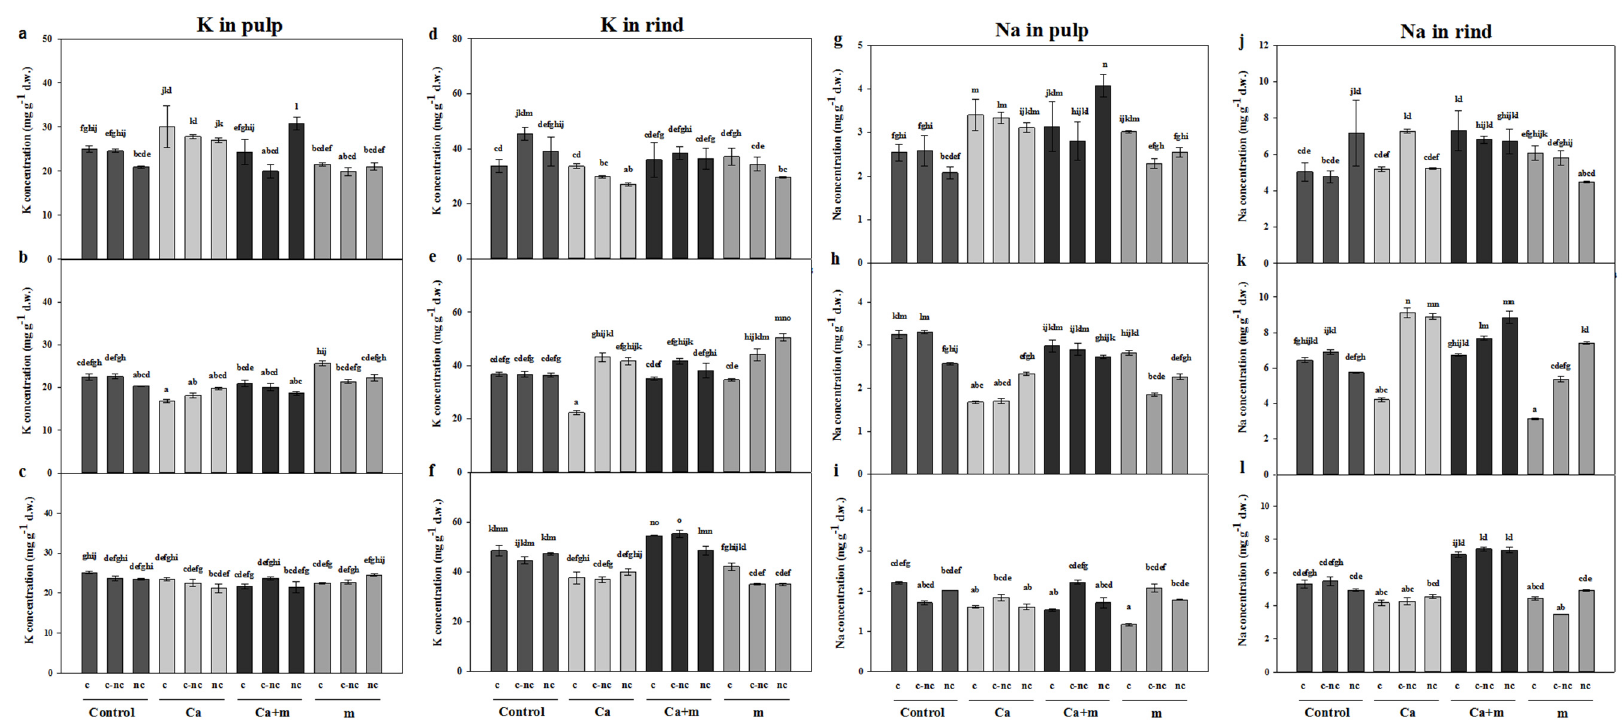
Figure 6. The K concentration (dry weight basis) in pulp, ( a ) control irrigation, ( b ) conductivity irrigation, and ( c ) double irrigation, and rind, ( d ) control irrigation, ( e ) conductivity irrigation, and ( f ) double irrigation. The Na concentration (dry weight basis) in pulp, ( g ) control irrigation, ( h ) conductivity irrigation, and ( i ) double irrigation, and rind, ( j ) control irrigation, ( k ) conductivity irrigation, and ( l ) double irrigation. The Ca treatment consisted of 8 mM CaCl 2 and 2 mM CaSO 4 , the Ca + m treatment consisted of a commercial mixture (Antisal gold, Nufol ® ) and the m treatment consisted of another commercial mixture (Microfold, Nufol ® ). Codes: c, cracked region in cracked fruit. c-nc, non-cracked region in cracked fruit. nc, non-cracked fruit. Statistical analysis was performed using SPSS 25.0.0.1 and included all the irrigation treatments, separating each element and each type of tissue. The values are the means ± SE of three individual analyses. Columns with di ff erent letters di ff er significantly according to Duncan’s test ( p = 0.05).